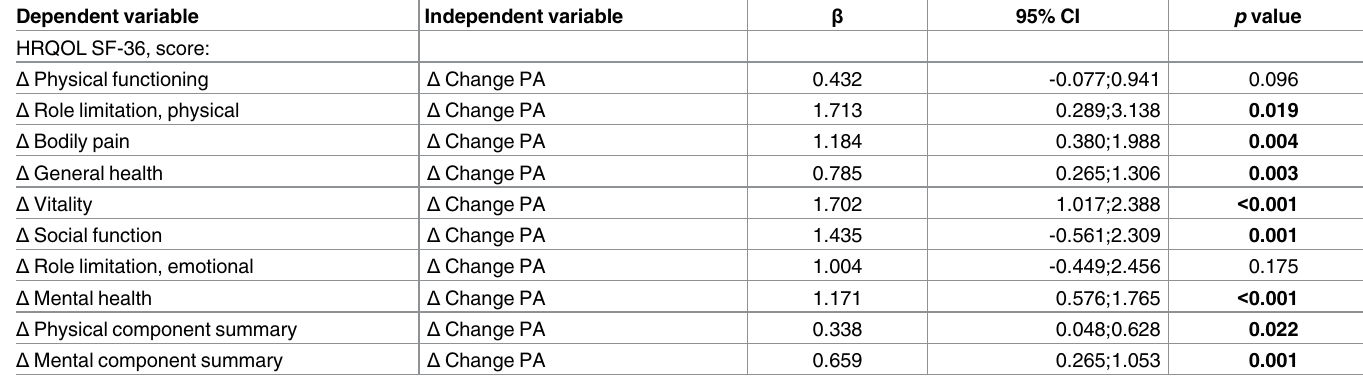
Table 7. Results for univariate linear regression analysis investigating the association between change in PA and health related quality of life (SF- 36) at 6-month follow-up a